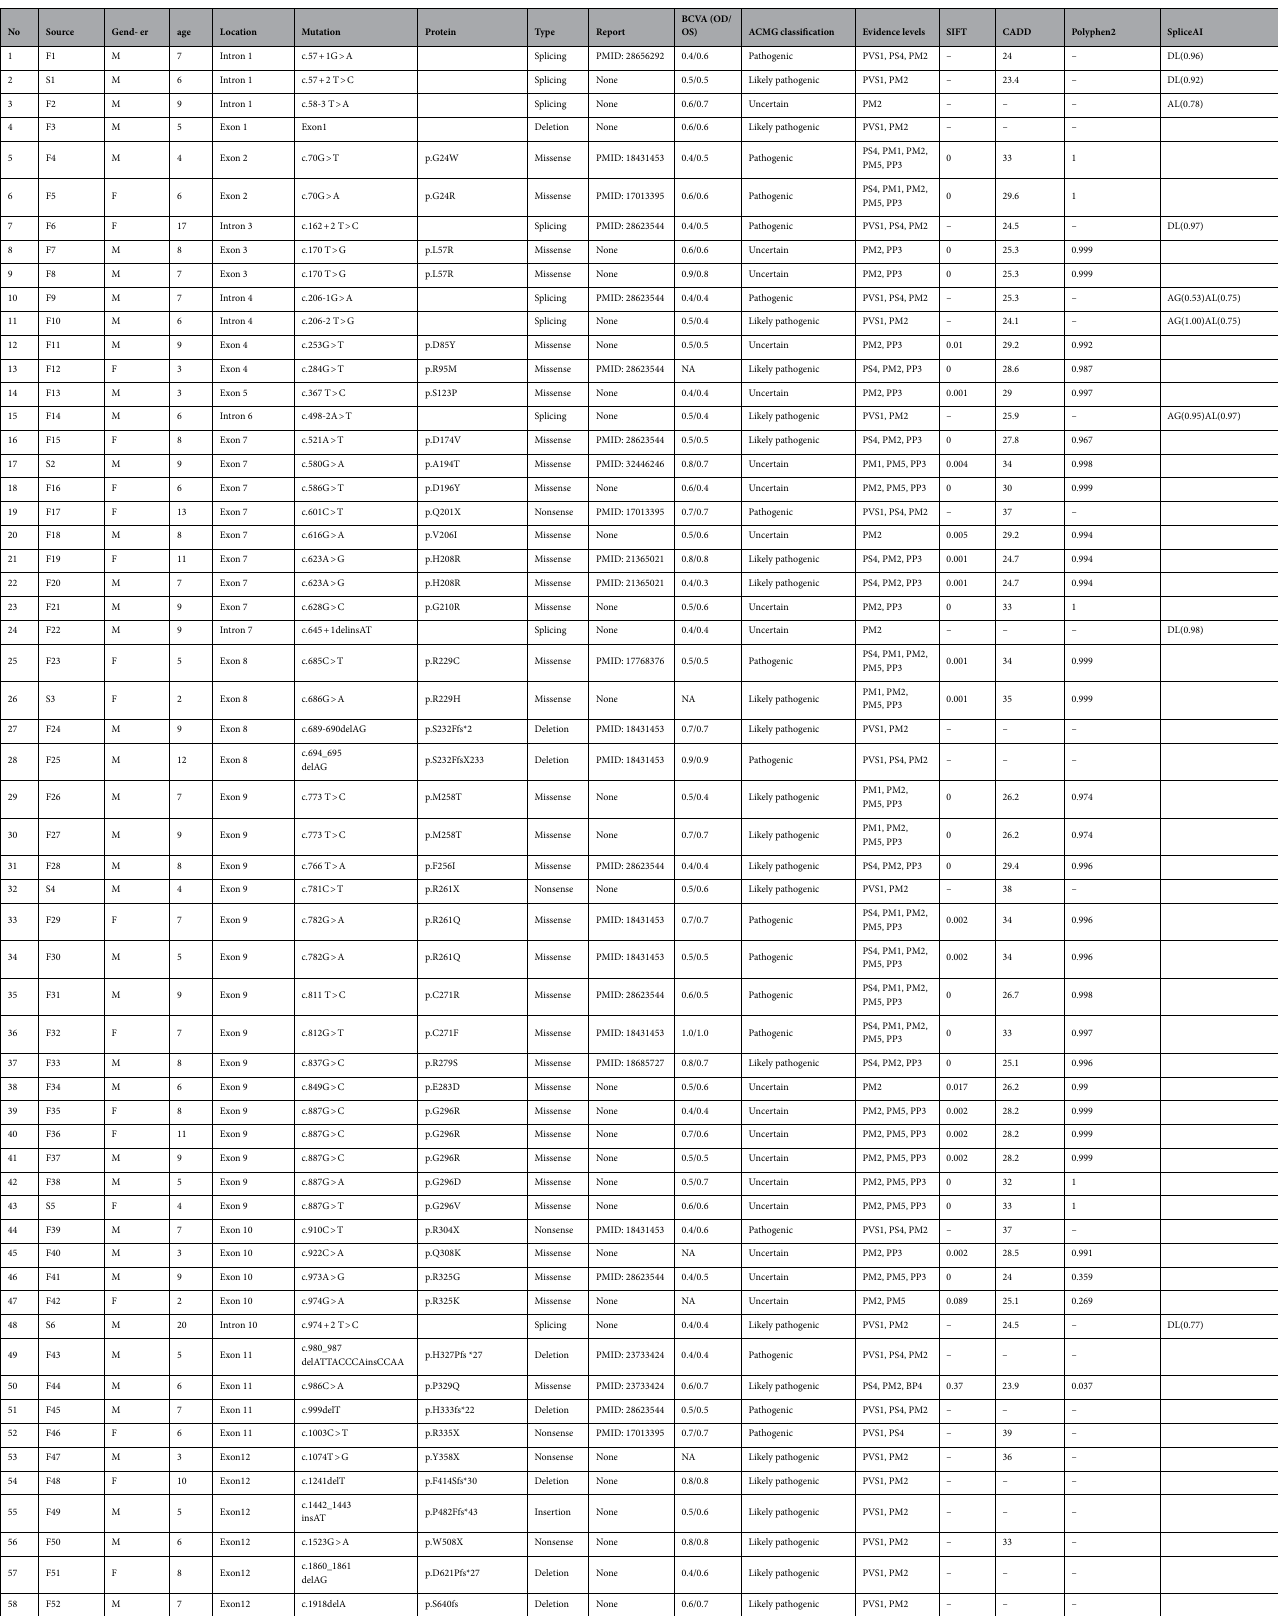
Table 1. Mutations of FRMD7 in 56 pedigrees and 34 sporadic patients with infantile